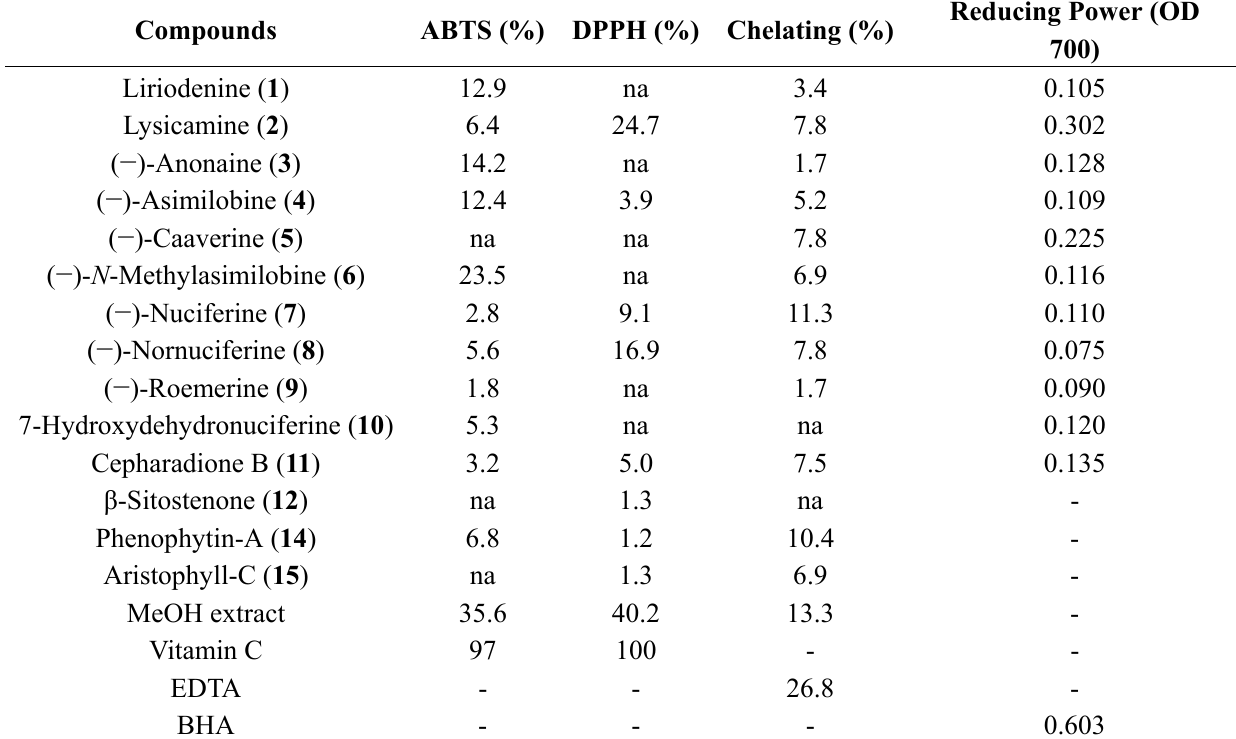
Table 1. Antioxidant activity of the extracted compounds at 100 μ